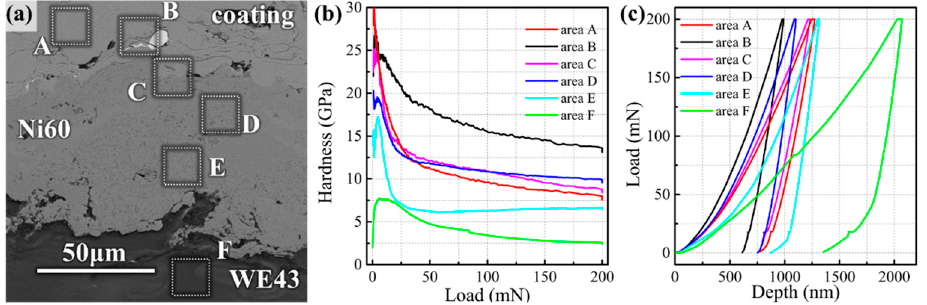
Figure 4. Mechanical properties at different areas of the coating cross-section: ( a ) selected areas of nanoindentation; ( b ) hardness-load curves; ( c ) load-depth curves.